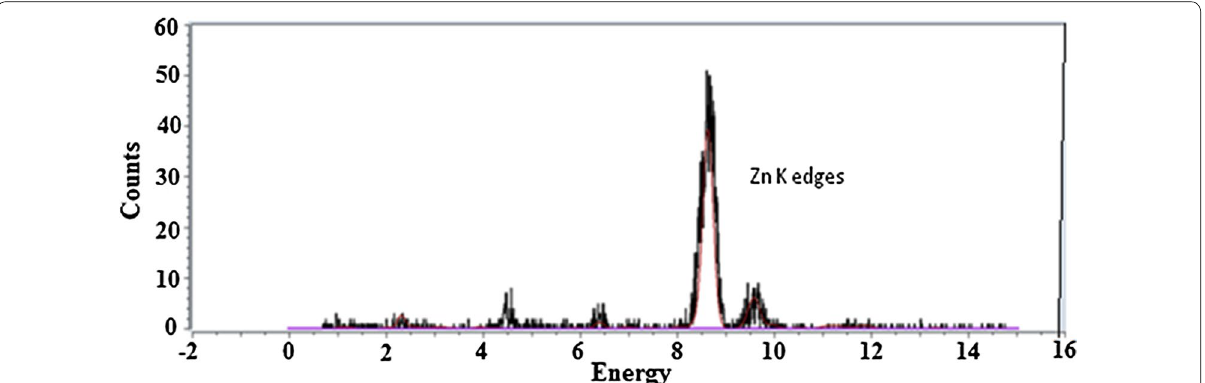
Fig. 3 Fluorescence spectra collected from a crystal of HR insulin, Insugen (I), to confirm the presence of